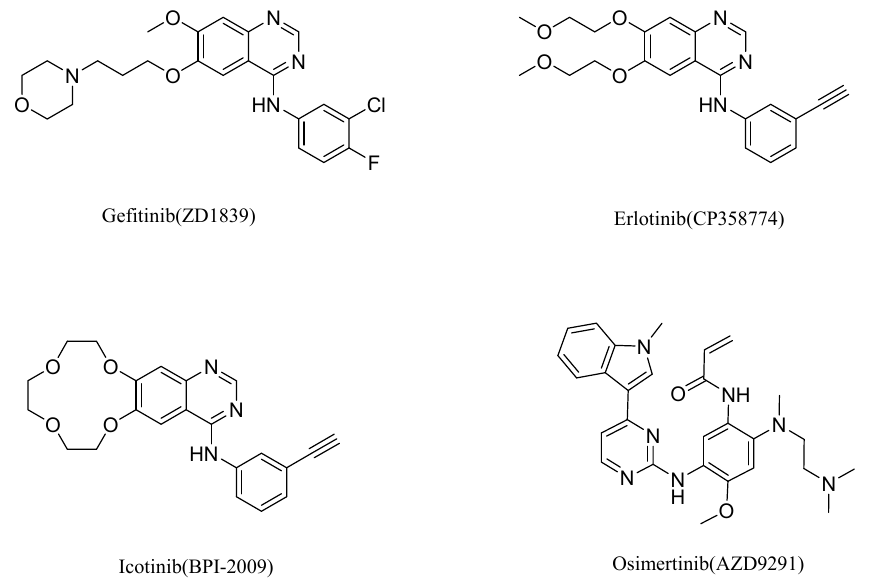
Figure 1. The structures of several approved epidermal growth factor receptor (EGFR) inhibitors.